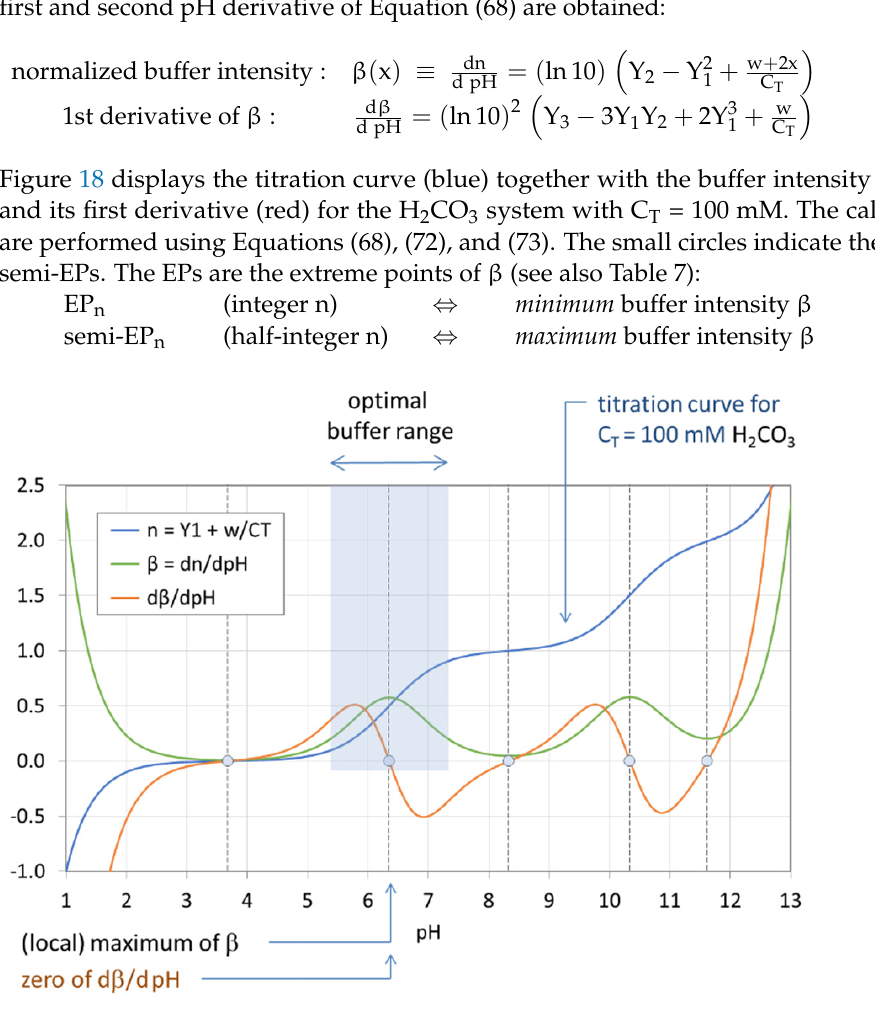
Figure 19. Normalized buffer capacity (blue), buffer intensity (green), and d β /dpH (red) for four acids and C T → ∞ .